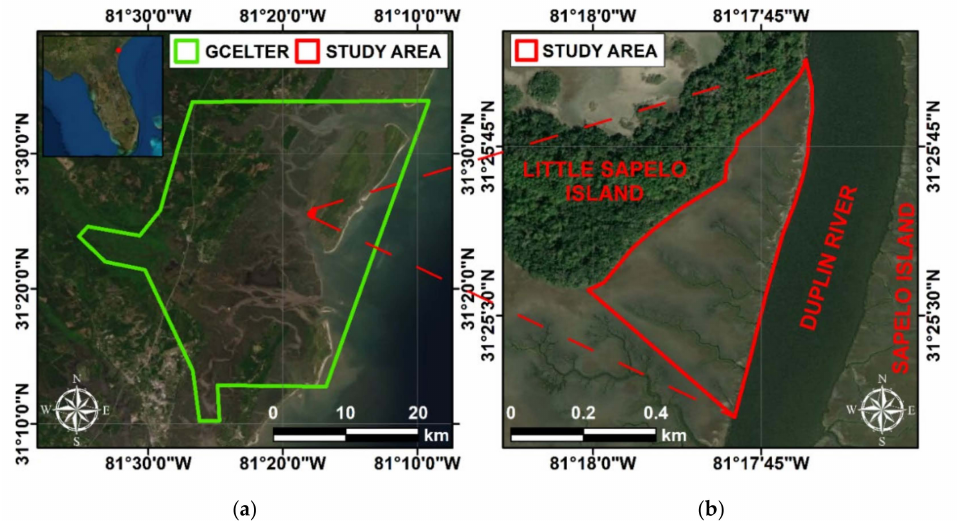
Figure 1. ( a ) The boundaries of the Georgia Coastal Ecosystem Long Term Ecological Research (GCELTER, in green). ( b ) Our study area, placed at the south-eastern boundary of Little Sapelo Island, in Georgia, USA (continuous red